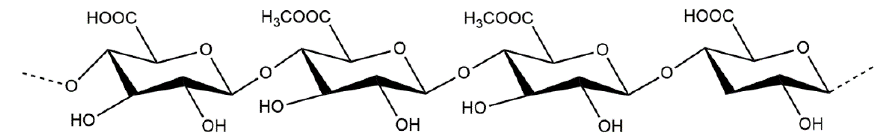
Figure 14. Schematic representation of pectin’s chemical structure.